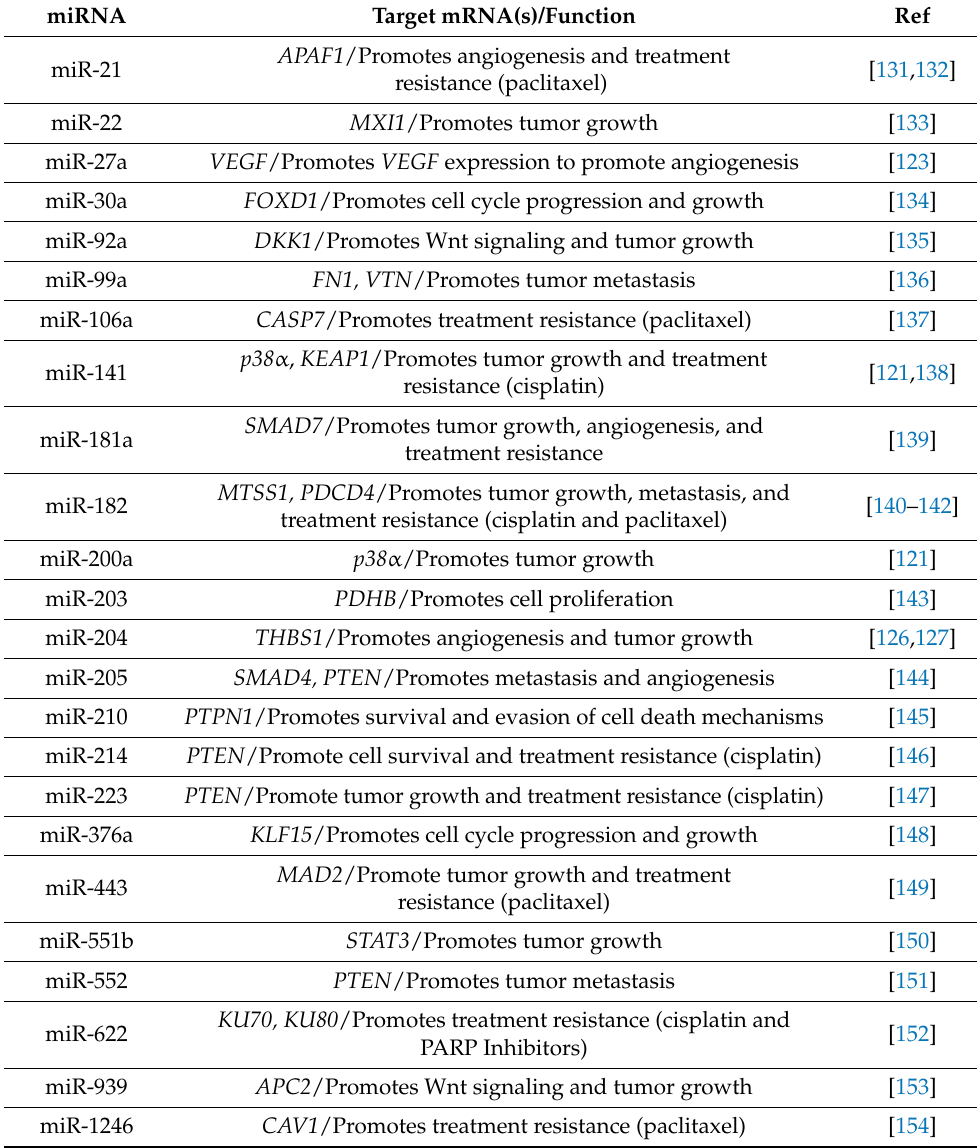
Table 1. miRNAs upregulated in OC cells that contribute to tumor growth and development, angiogenesis, and therapeutic resistance. miRNA Target mRNA(s)/Function Ref APAF1 /Promotes angiogenesis and treatment miR-21 resistance (paclitaxel)